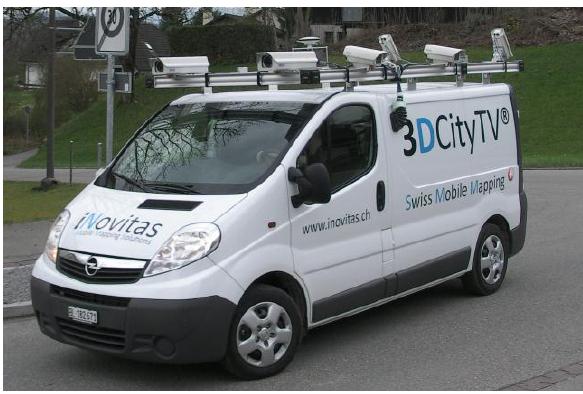
Figure 1. Stereo vision based mobile mapping system